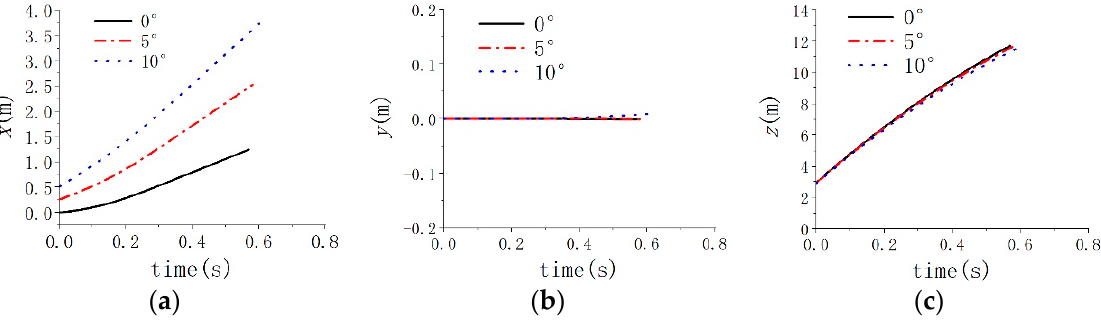
Figure 9. Centroid coordinates of vehicle in case 7, 8, 9. ( a ) Vehicle centroid X -axis coordinates. ( b ) Vehicle centroid Y -axis coordinates. ( c ) Vehicle centroid Z -axis